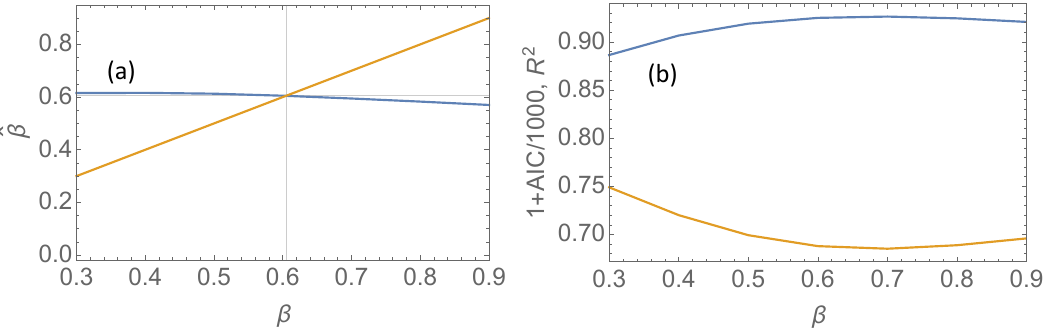
Figure 2. ( a ) The blue curve is ˆ β plotted against β which was estimated from the variogram of the residual signal obtained after regression using fingerprints obtained from filtering forcing signals by the response function, G ( t ) = ct β /2 − 1 . The yellow curve is the straight line through the origin with unit slope. ( b ) The blue curve is R 2 of the regression plotted against β which was used in the response function. The yellow curve is 1 + AIC /1000 versus β , where AIC is the Akaike information